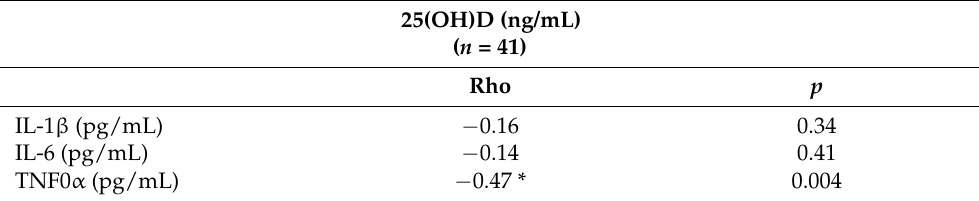
Table 4. Correlation between 25(OH)D levels and IL-6, IL-1 β , and TNF- α in athletes.